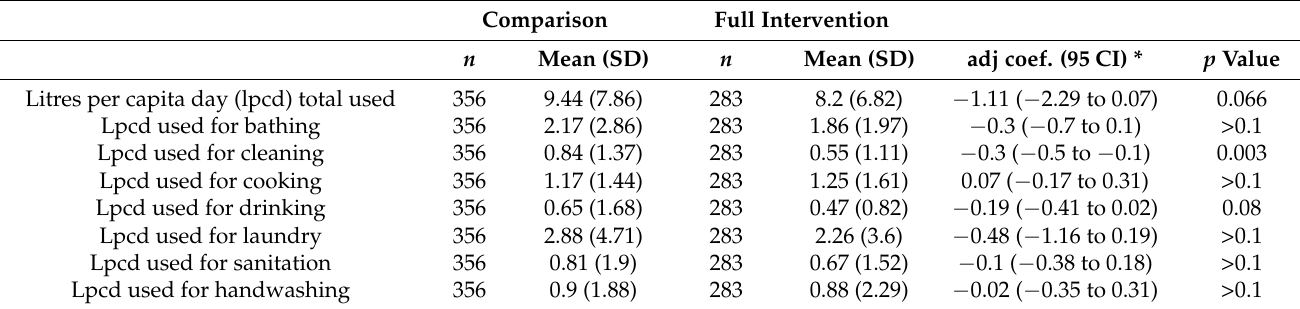
Table 4. Water use outcomes in Goma.